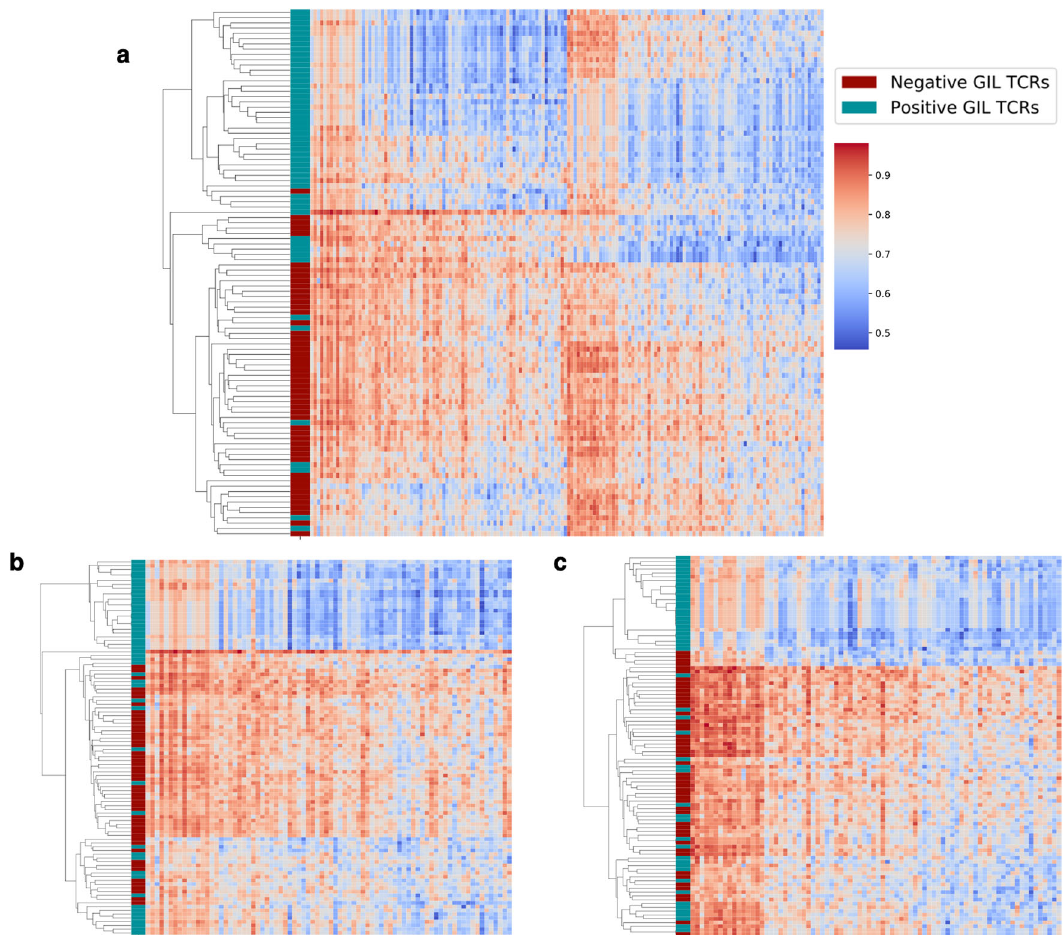
Fig. 7 Hierarchical-clustered heatmaps of 50 positive GIL TCRs and 50 negatives. The clustering was performed using both α - and β -sequences ( a ) or using single chains ( α chain in b , β chain in c ). Each row in the heatmap represents a TCR sequence in the max-pooled feature-space representation; the color bar on the side of each plot delineates whether the TCR is positive or negative. Cosine distance was used as a metric for clustering.